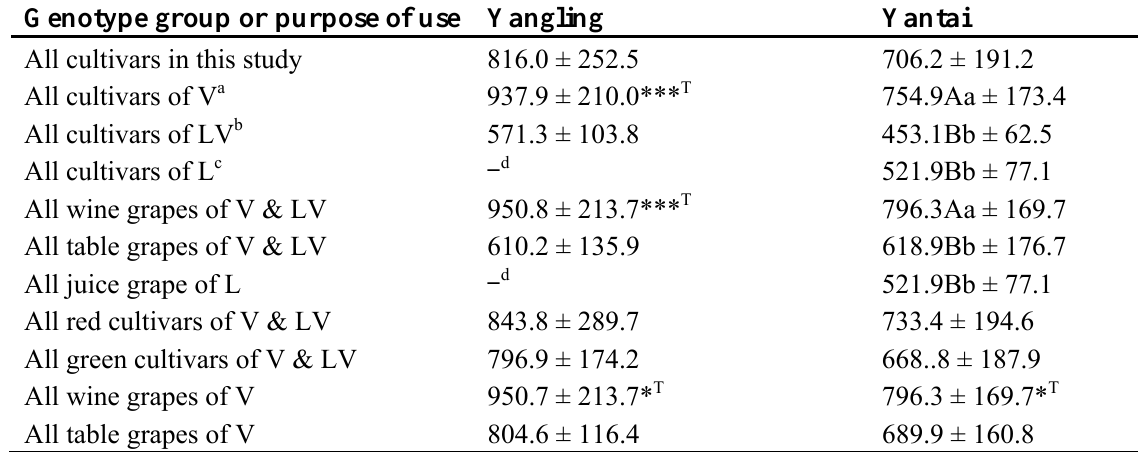
Table 2. Comparison of trans -resveratrol contents (mean value ± S.D., mg kg − 1 of FW) in